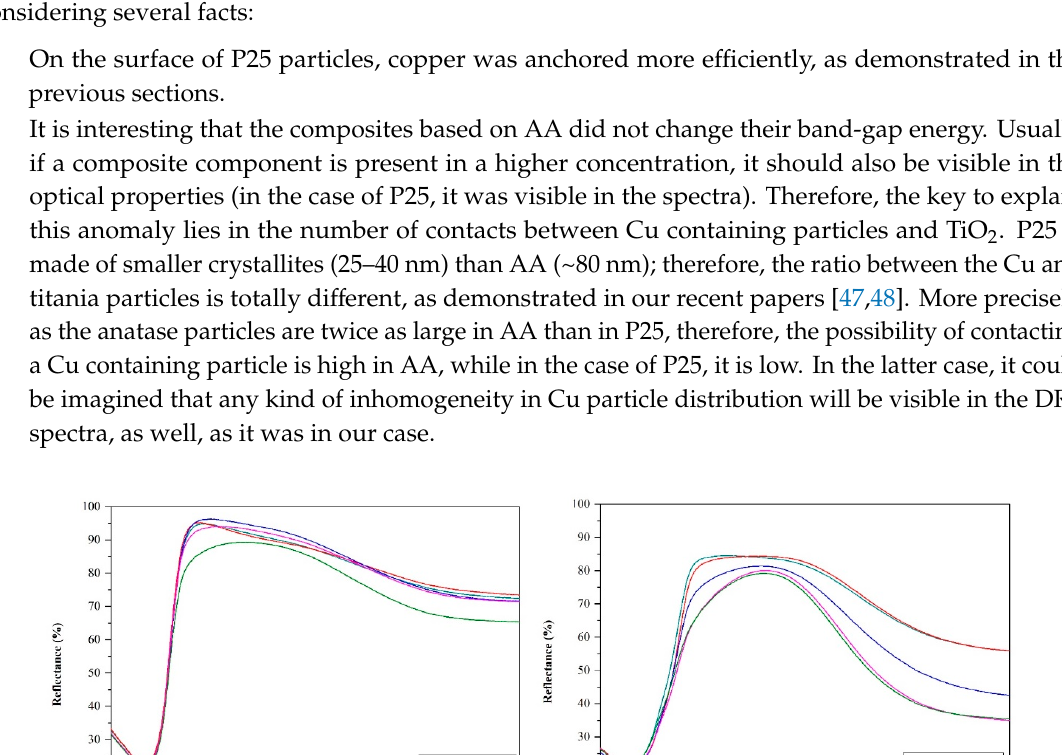
Figure 3. Element mapping of P25-5Cu composite.